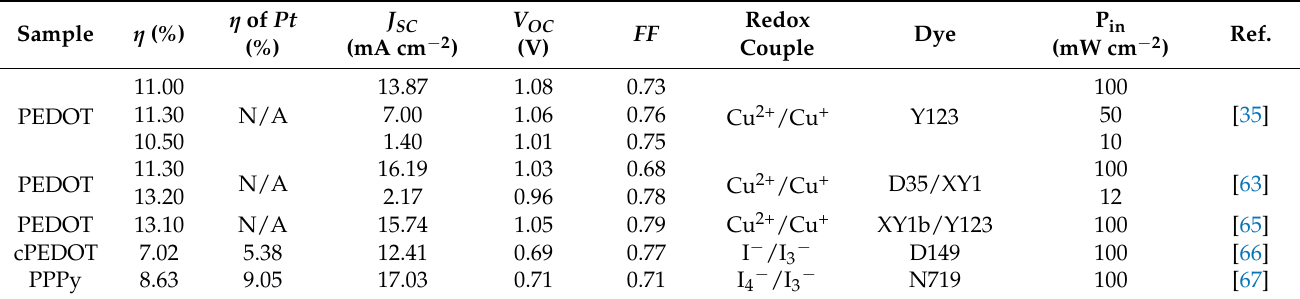
Table 3. The photovoltaic parameters of various conductive polymer-based electrocatalysts in the DSSC are compared under simulated solar light conditions.